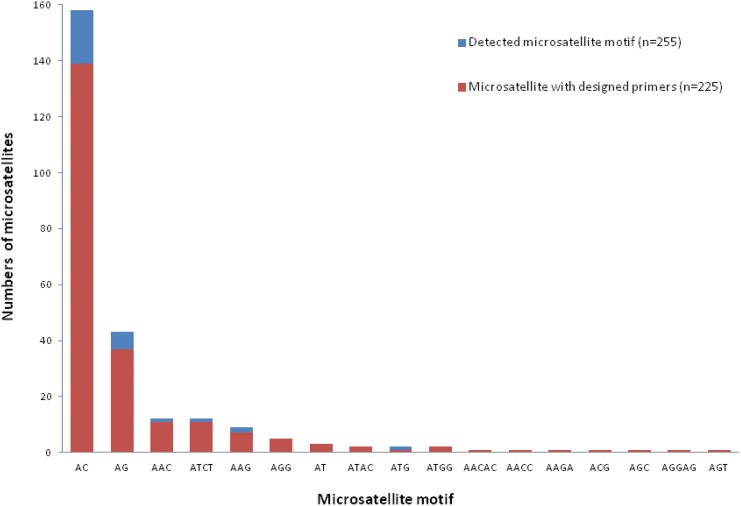
Number of microsatellites detected within good quality reads for primer design purpose and number of microsatellites with a successfully designed primer pair by motif type.